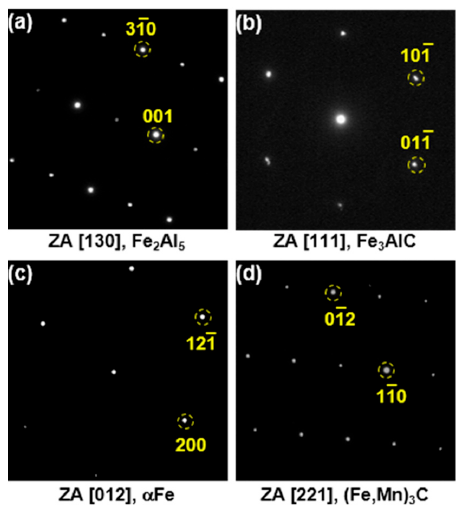
Figure 10. Diffraction pattern obtained from area indicated by 1–4 in ( a ) of Figure 7: ( a ) 1; ( b ) 2; ( c ) 3; ( d ) 4.